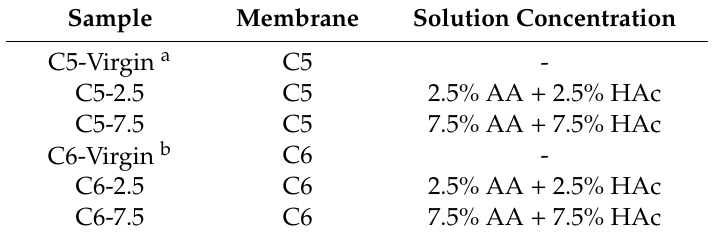
Table 2. Nomenclature and the acid solutions used for immersing the RO